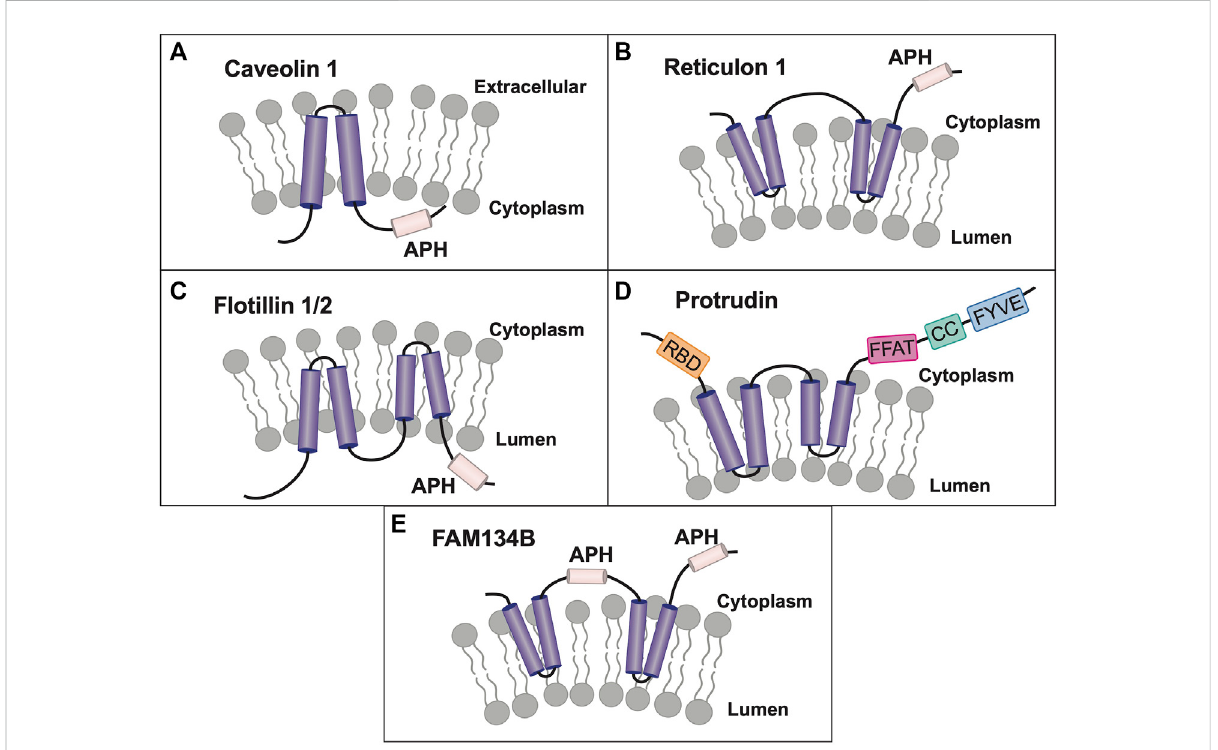
FIGURE 7 Caveolin and Other Membrane Shaping Adapter Proteins (MSAPs). (A). Transmembrane topology of Caveolin-1 (Cav-1). Unlike Yip family members, caveolins possess only a single hairpin domain with a carboxy terminal APH, however they meet all of the criteria to be termed MSAPs (Bauer and Pelkmans, 2006). (B). Reticulons share the most homology with REEP/Yop1p, possessing two membrane-inserted hairpin structures and a possible carboxy terminal APH (Shibata et al., 2008; Breeze et al., 2016). (C). Flotillin-1/2 are membrane-associated proteins found on the plasma membrane cytoplasmic face. They possess two hairpin structures, found within an amino terminal prohibitin-like domain (PHB) and a carboxyterminalAPH(Morrowetal.,2002). (D). Protrudin,abindingpartnerofREEPsandatlastins,alsohastwohairpindomainsthatappeartoinsert into the membrane. However, instead of an APH domain, they possess a FYVE domain that discriminates between different types of phosphoinositides found in lipid rafts (Chang et al., 2013). In addition, it possesses an amino terminal ‘ Rab-binding domain ’ (RBD) and carboxy terminal ‘ coiled-coil ’ (CC) and ‘ two phenylalanine ’ s (FF) in an acidic tract ’ (FFAT) domains. (E). FAM134B, a selective ER-phagy receptor, has been recently demonstrated to possess two pairs of dual hairpin structures, with an APH domain localized between them and a carboxy terminal APH, similarto otherYipfandREEP familymembers(Bhaskaraetal.,2019).Modeled proteins arenotshowntoscale